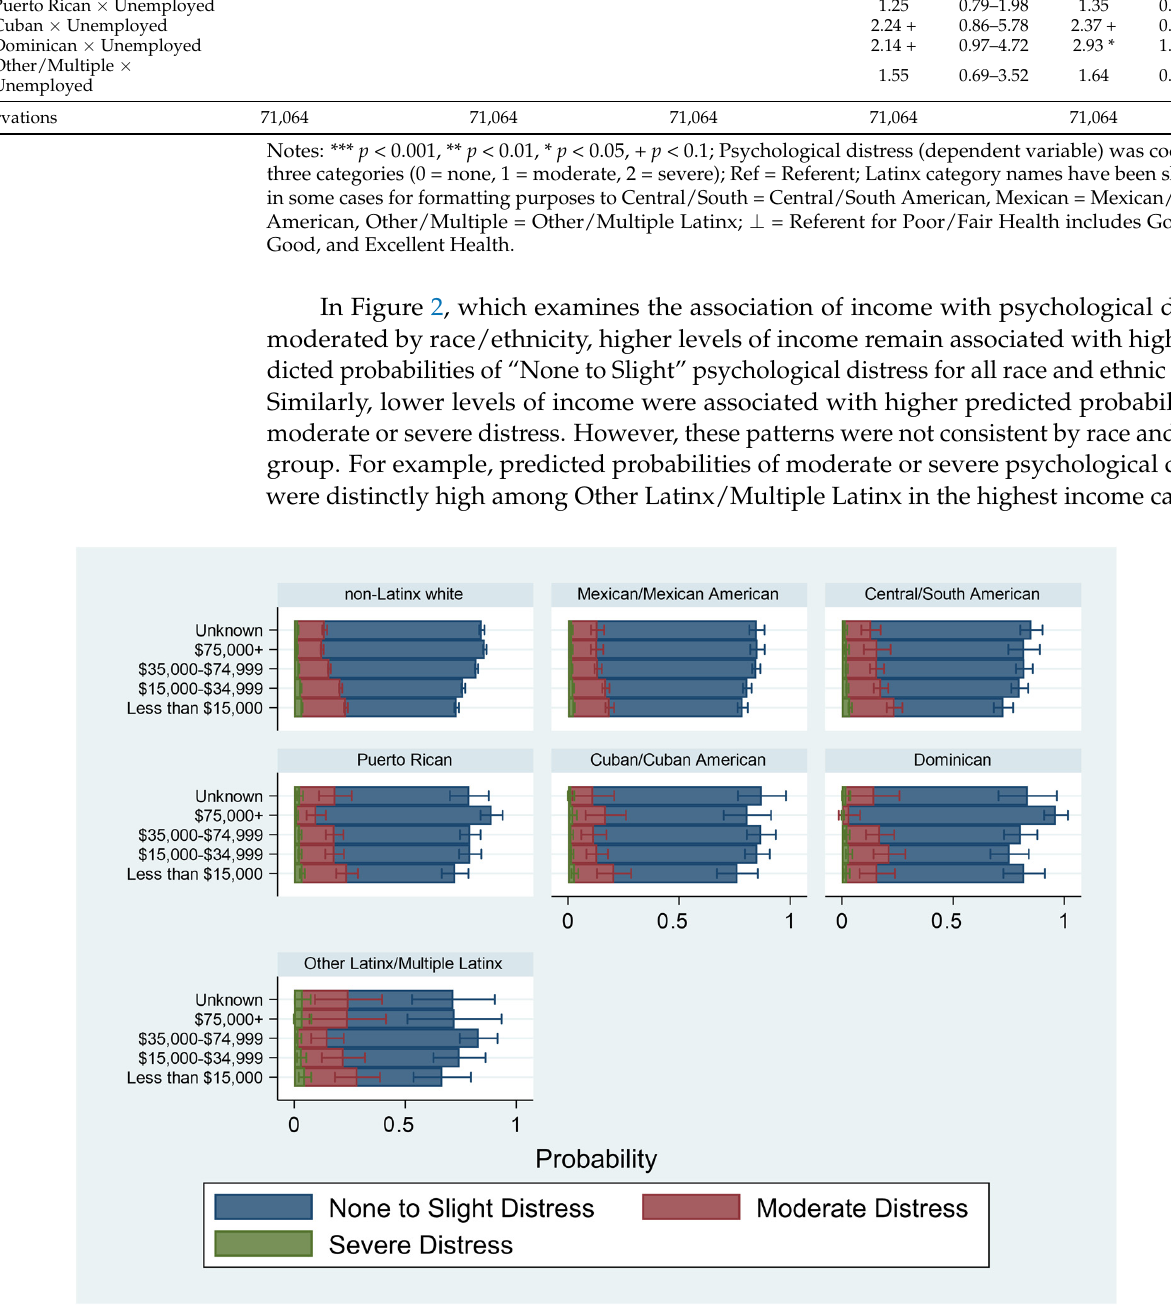
Figure 2. Predicted Probabilities of Level of Psychological Distress by Income and Racial/Ethnic Subgroup, 2014–2018 National Health Interview Survey ( n = 71,064). Notes: Figure based on Table 4, Model 2. Accounts for demographic, social, and health factors.